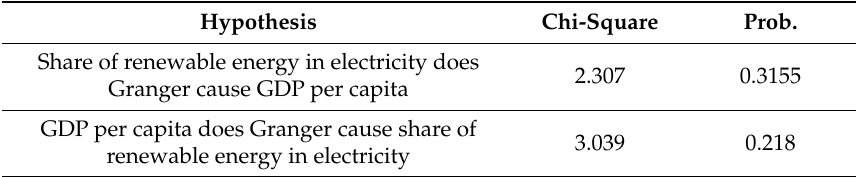
Table 2. Granger causality test applied on panel data to explain the connection between the share of renewable energy in electricity and GDP per capita in the EU-28 (2007–2017). Hypothesis Chi-Square Prob. Share of renewable energy in electricity does 2.307 0.3155 Granger cause GDP per capita GDP per capita does Granger cause share of 3.039 0.218 renewable energy in electricity Source: own